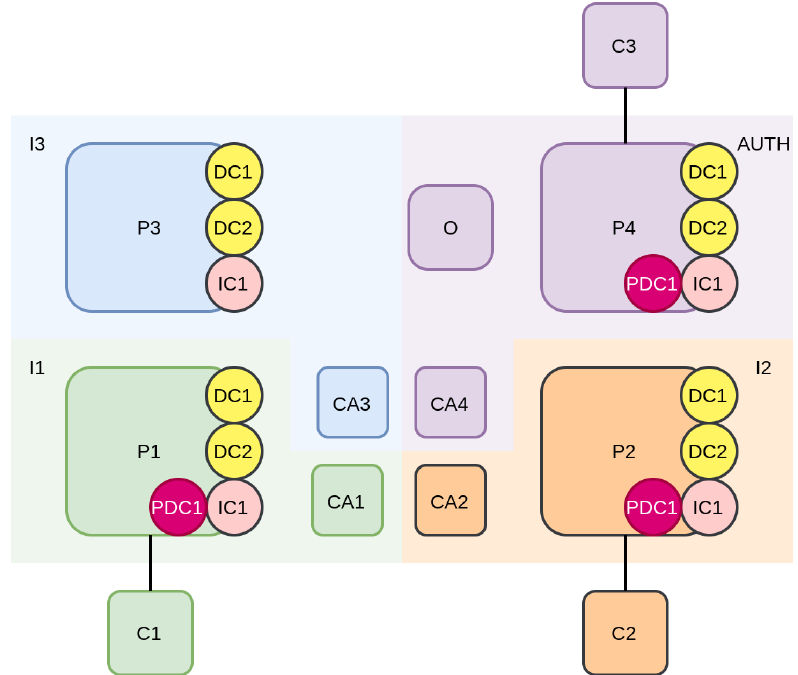
Figure 6. Layout of Hyperledger fabric